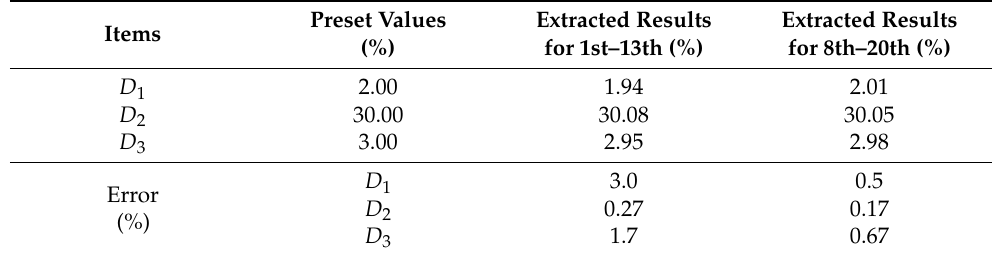
Table 1. Extracted results from 1st to 13th order or 8th to 20th order harmonic amplitudes.